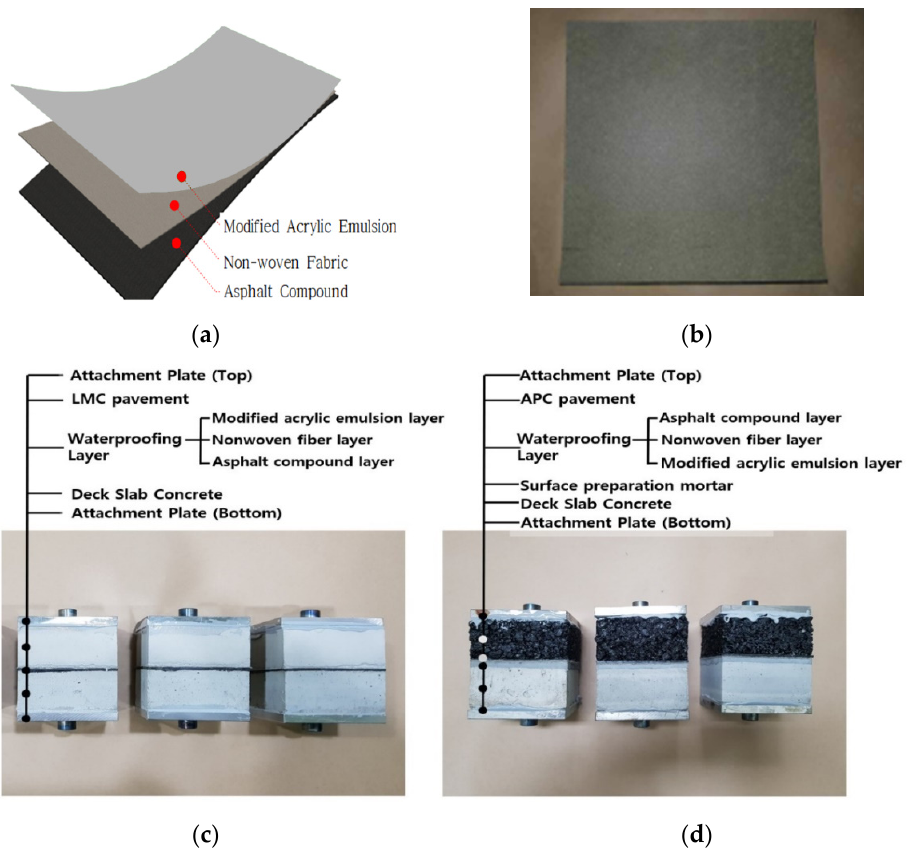
Figure 5. APC and LMC pavement specimens; ( a ) a double-sided waterproofing sheet, ( b ) surface of waterproofing sheet, ( c ) LMC pavement specimen with applied waterproofing sheet, ( d ) APC pavement specimen with applied waterproofing